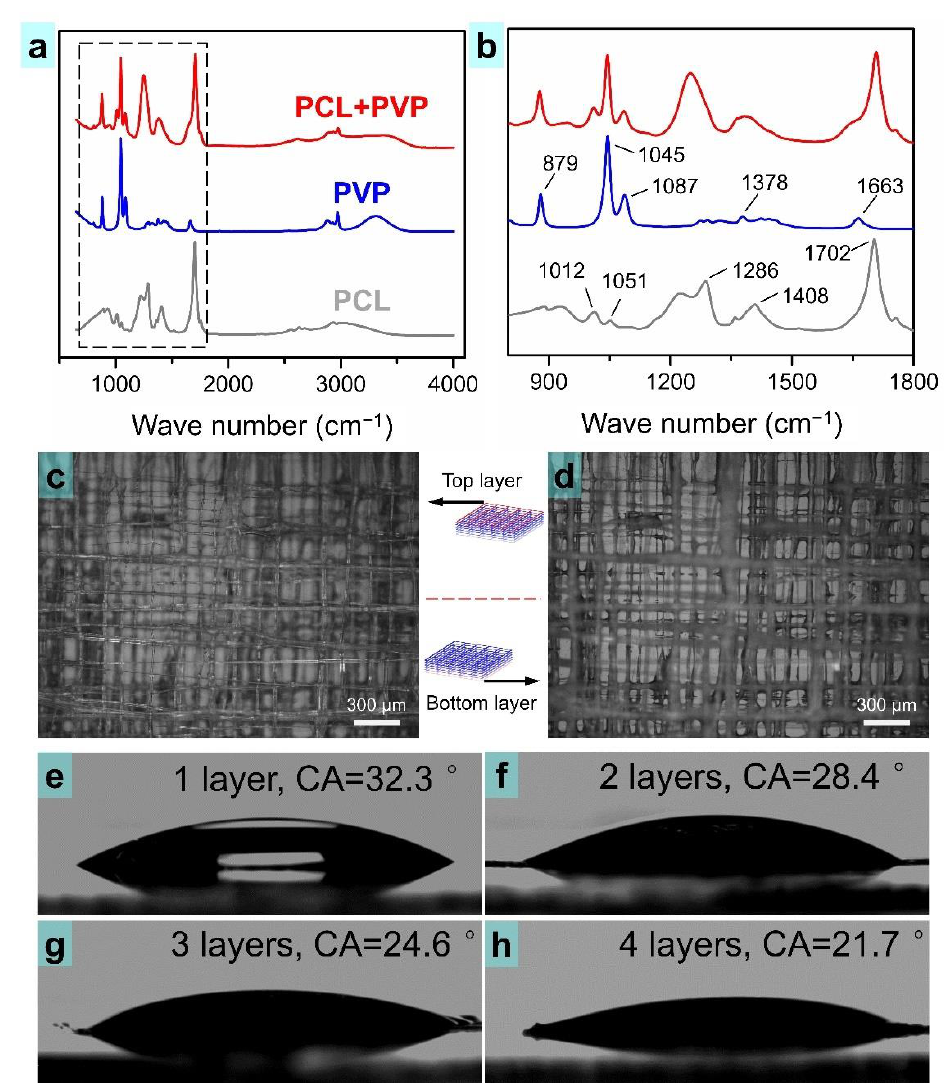
Figure 8. ( a , b ) FTIR spectra and its characteristic peaks. ( c , d ) Soaking scaffold in deionized water for 3 days; ( e – h ) Contact angle measurements of the composite scaffold with 1, 2, 3, and 4 layers,